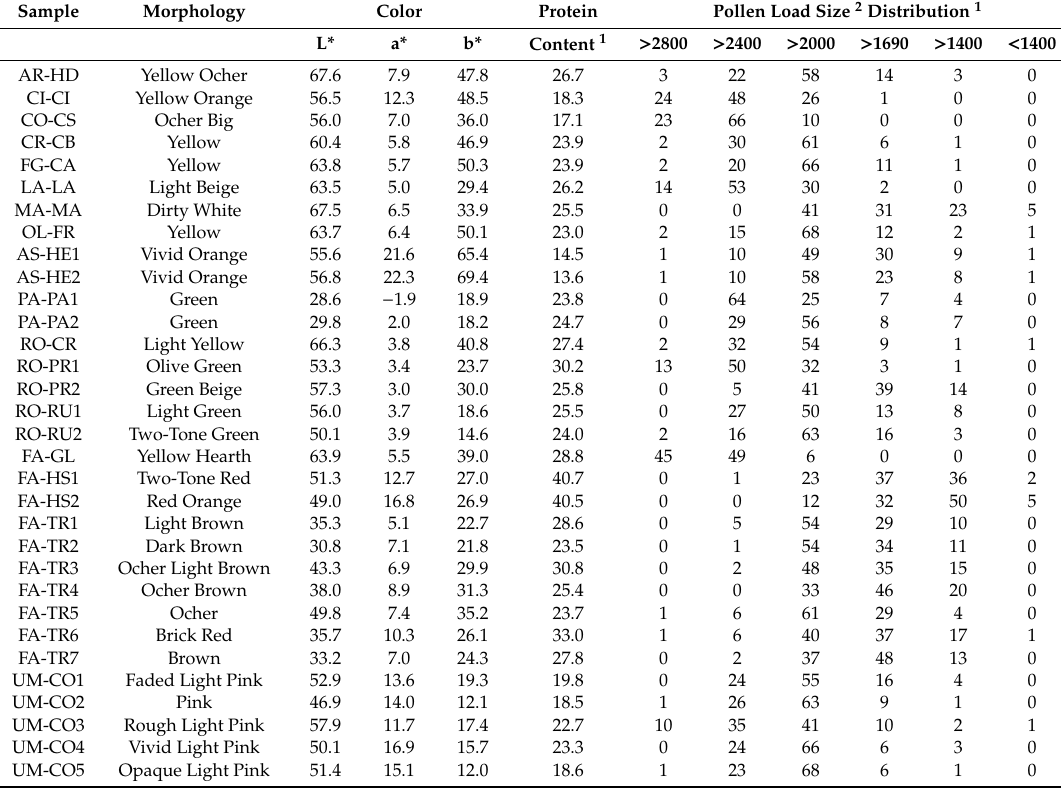
Table 2. Morphology, instrumental color data, protein content and pollen load size distribution of bee pollen